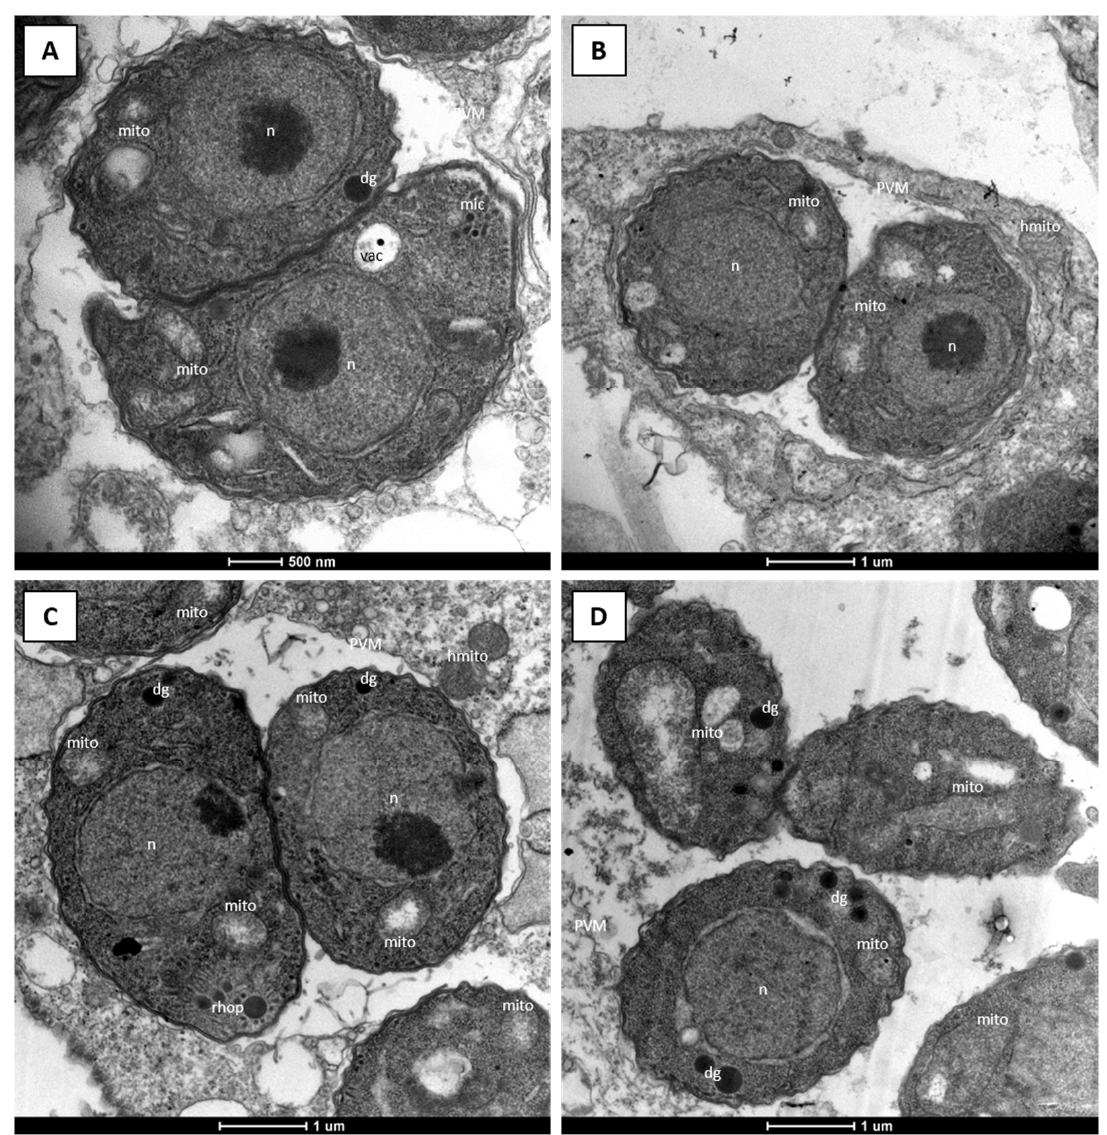
Figure 5. TEM of T. gondii Me49 tachyzoites cultured in vitro in HFF host cells. Long-term treatment with increasing concentrations of RMB060 and DCQ over 52 days, with end concentrations of 0.3 µM and 0.5 µM, respectively. ( A ) and ( B ) show TgMe49 treated with RMB060 and TgMe49 treated with DCQ are shown in ( C ) and ( D ). dg = dense granules; mic = micronemes; mito = mitochondrion; hmito = host cell mitochondrion; n = nucleus; hnuc = host cell nucleus; PVM = parasitophorous vacuole membrane; rhop = rhoptries; vac = cytoplasmic vacuole.